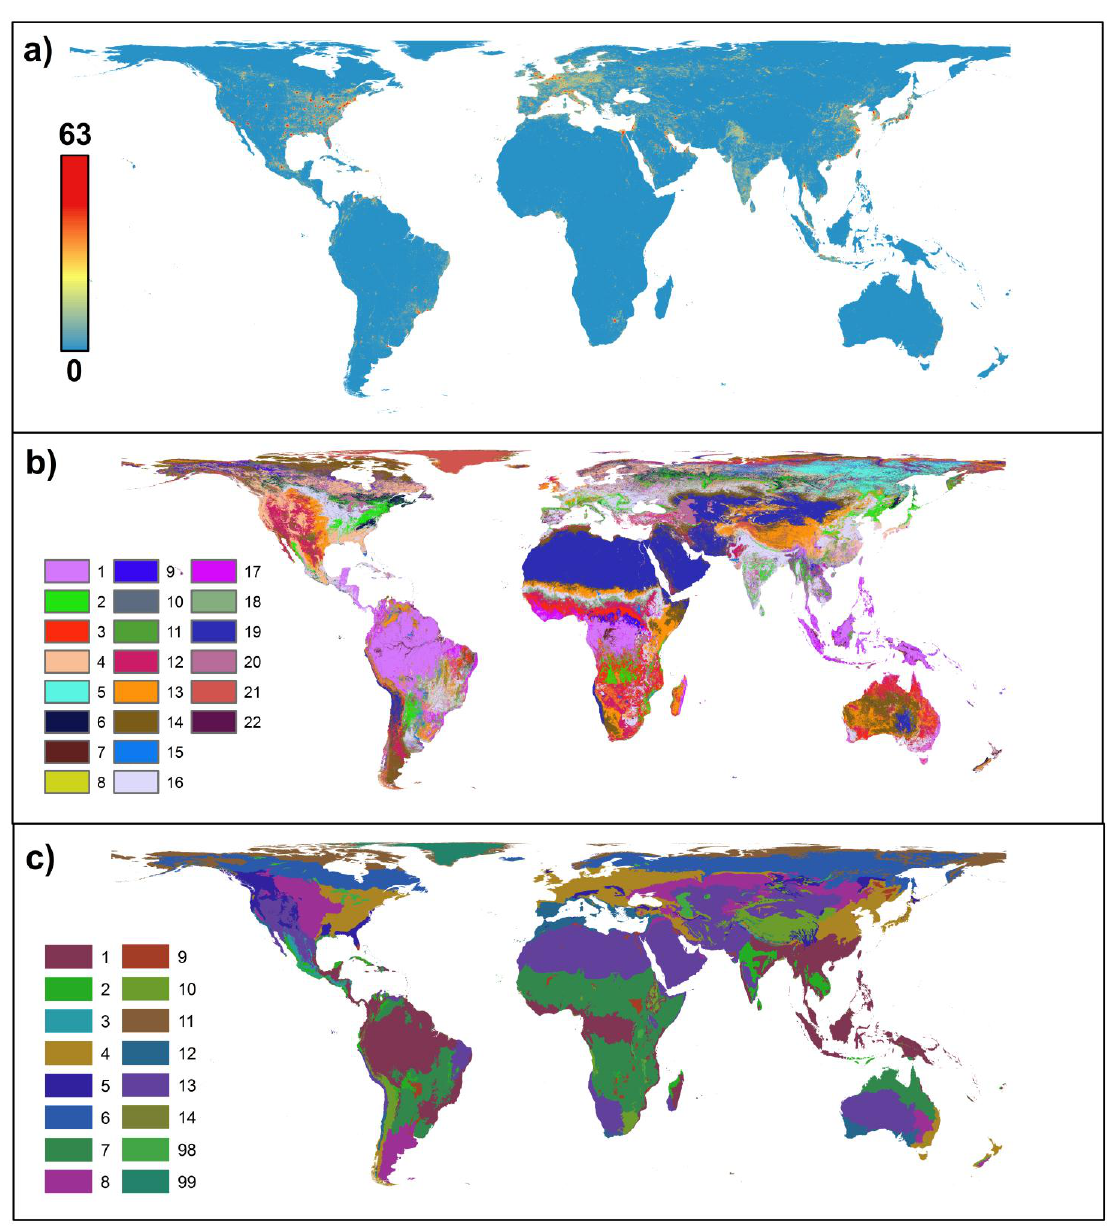
Figure 1. ( a ) Global nighttime lights image from DMSP data, 2012; ( b ) Global landcover from GLC2000, aggregated from 1 km resolution; ( c ) Global terrestrial ecoregions from World Wildlife Fund (WWF). Categories in panels b and c are coded as in Table